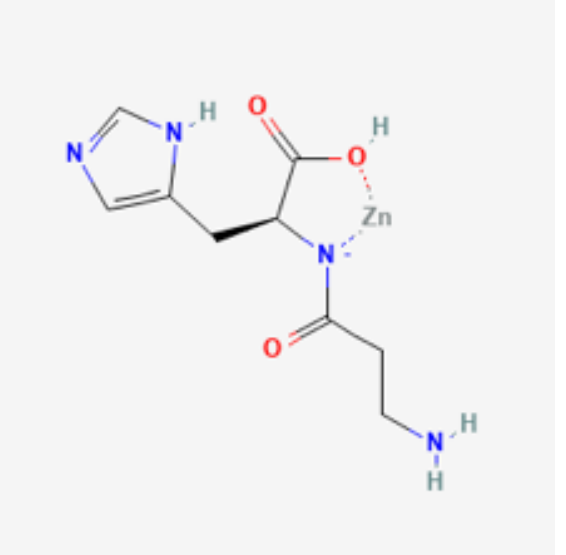
Figure 1. Chemical structure of polaprezinc. Courtesy of the U.S. National Library of Medicine [23].